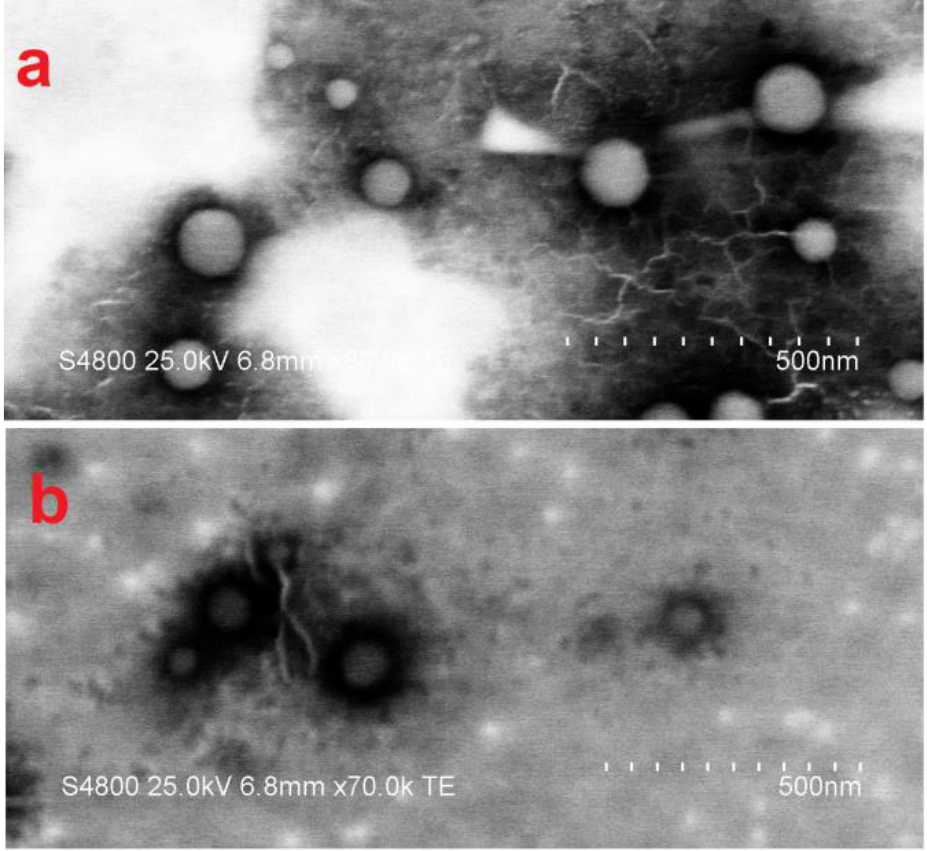
Figure 2. TEM images of the latex particles: ( a ) Latex E1, ( b ) Latex E2.